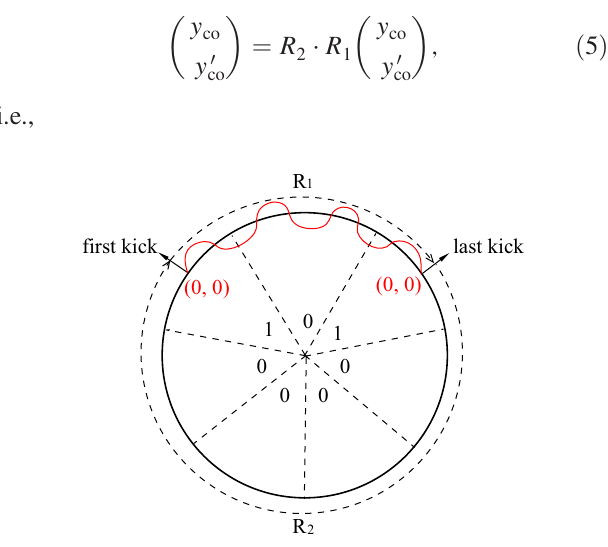
FIG. 3. A large multiturn ring. The vertical tune of the small ring is 0.25. The KAC pattern is KAC101000. Seven rings are concatenated in this example. Two rings with kicker turn-on are labeled with “ 1 ” , other rings with kicker off are labeled with “ 0 ”